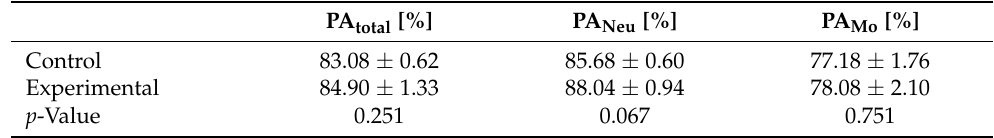
Table 4. Effect of humic substances on the phagocyte activity in piglets’ blood evaluated as percentage of active phagocytes—phagocytic